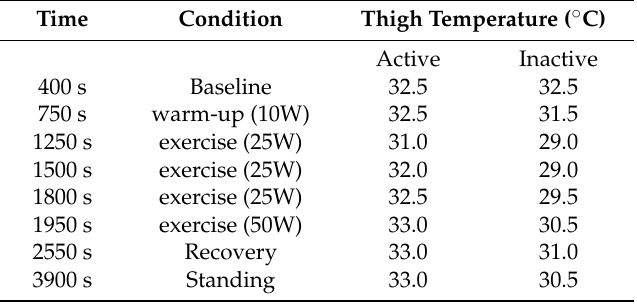
Table 1. Skin temperature in active and inactive thighs during the whole experimental